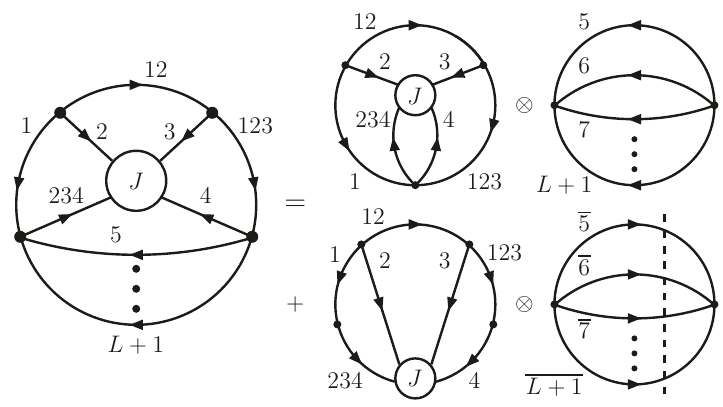
Figure 2 . Diagrammatic representation for the factorized opening of the multiloop N 4 MLT uni- versal topology . Only the on-shell cut of the last MLT-like subtopology with reversed momentum flow is